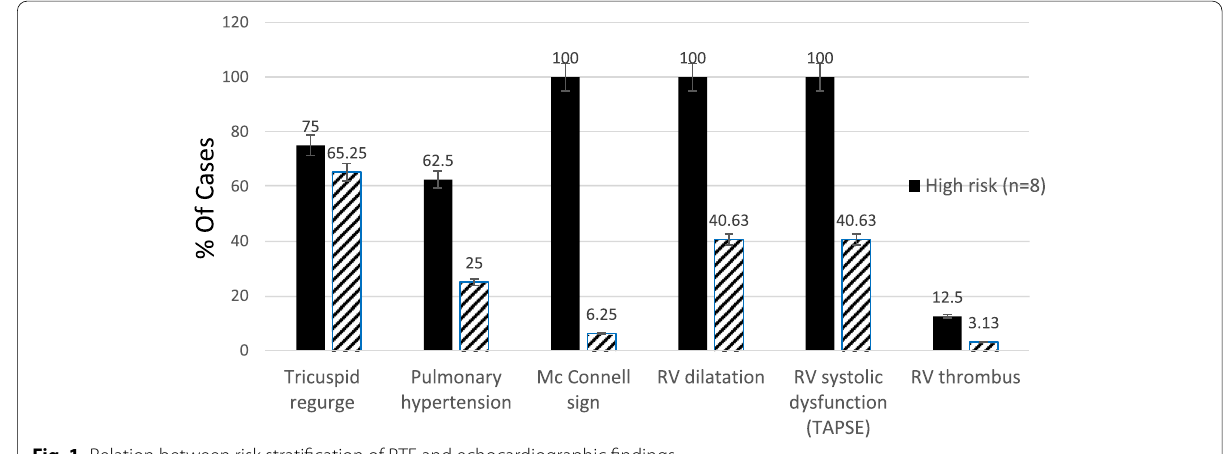
Fig. 1 Relation between risk stratification of PTE and echocardiographic findings